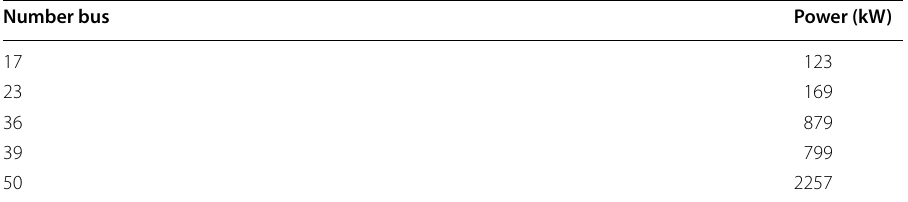
Table 4 Parameters of placement and sizing under the output power factor at unit in the 69-bus